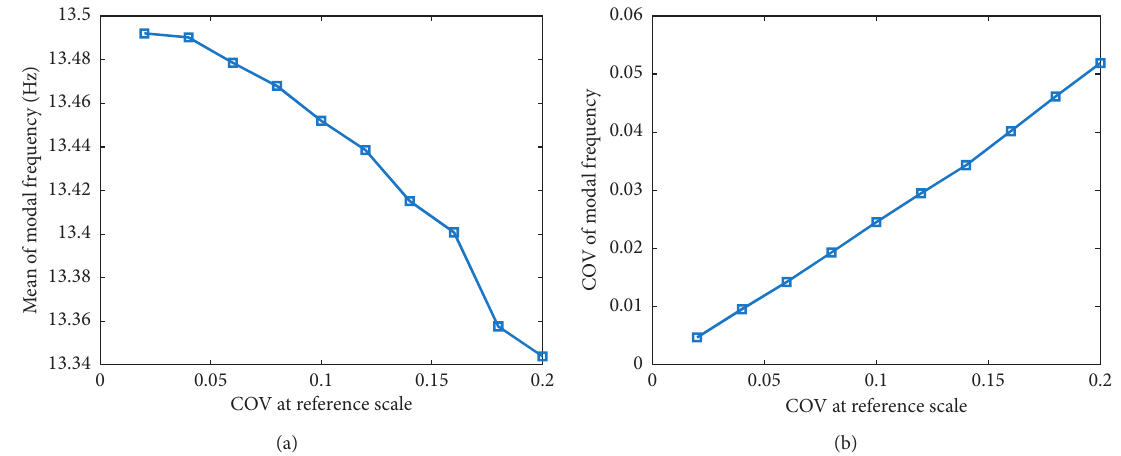
Figure 12: Statistics of the first-order modal frequency for different values of COV at the reference scale: (a) mean and (b) COV. The mesh size is 4 times the reference size.